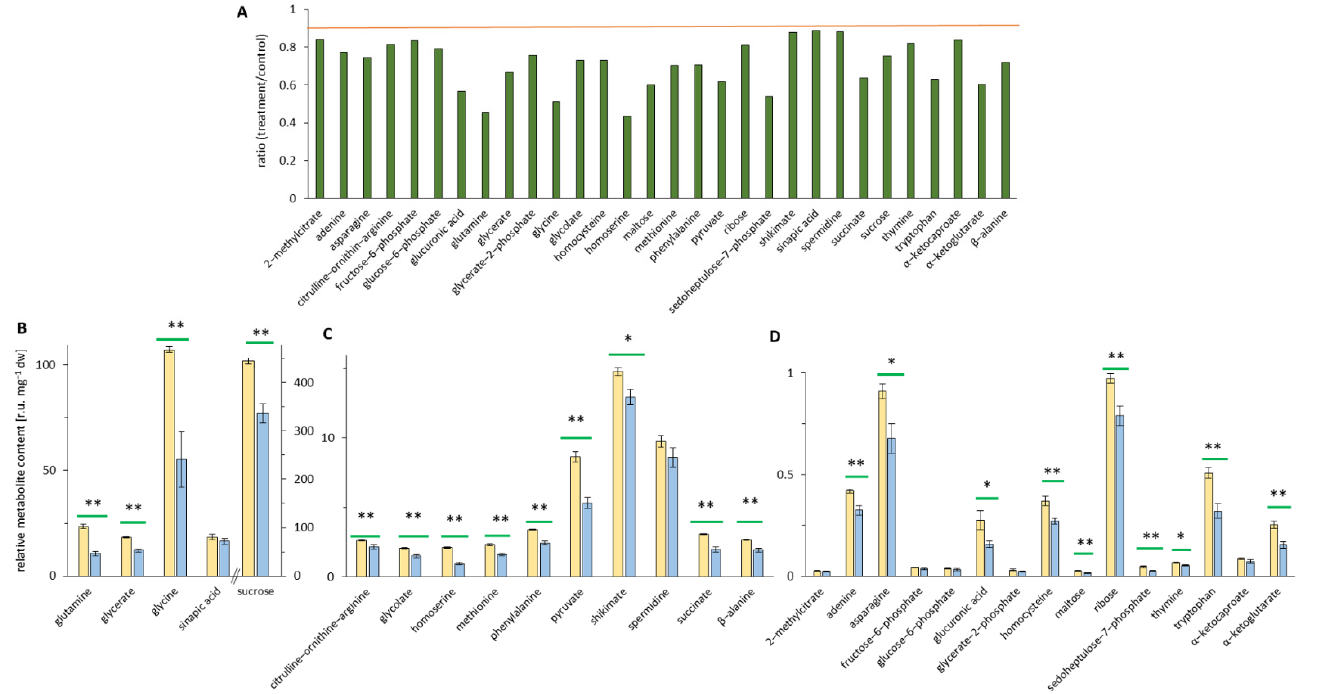
Figure 6. Metabolomic analysis in Arabidopsis thaliana plants with a ratio of treatment/control < 0.9. In 30-day-old plants (Col-0) after 48 h of EMF irradiation, the relative metabolite levels of treatment and control extracts were measured using GC–MS. Control samples are given in yellow, and the treated samples are in blue. ( A ) Overview of downregulated ratio of the relative metabolite content between treated and control extract metabolites (< 0.9, orange bar). ( B ) Metabolites present at high levels [r.u. mg − 1 dry weight]. ( C ) Metabolites present at intermediate levels [r.u. mg − 1 dry weight]. ( D ) Metabolites present at low levels [r.u. mg − 1 dry weight]. Independent experiments = 3, n = 6, means ± SE, Student’s t -test, p < 0.01 **, and p < 0.05 *, indicated by green bars. There is a significant ( p < 0.01/ p < 0.05) downregulation of the metabolites between control (yellow) and treatment (blue).